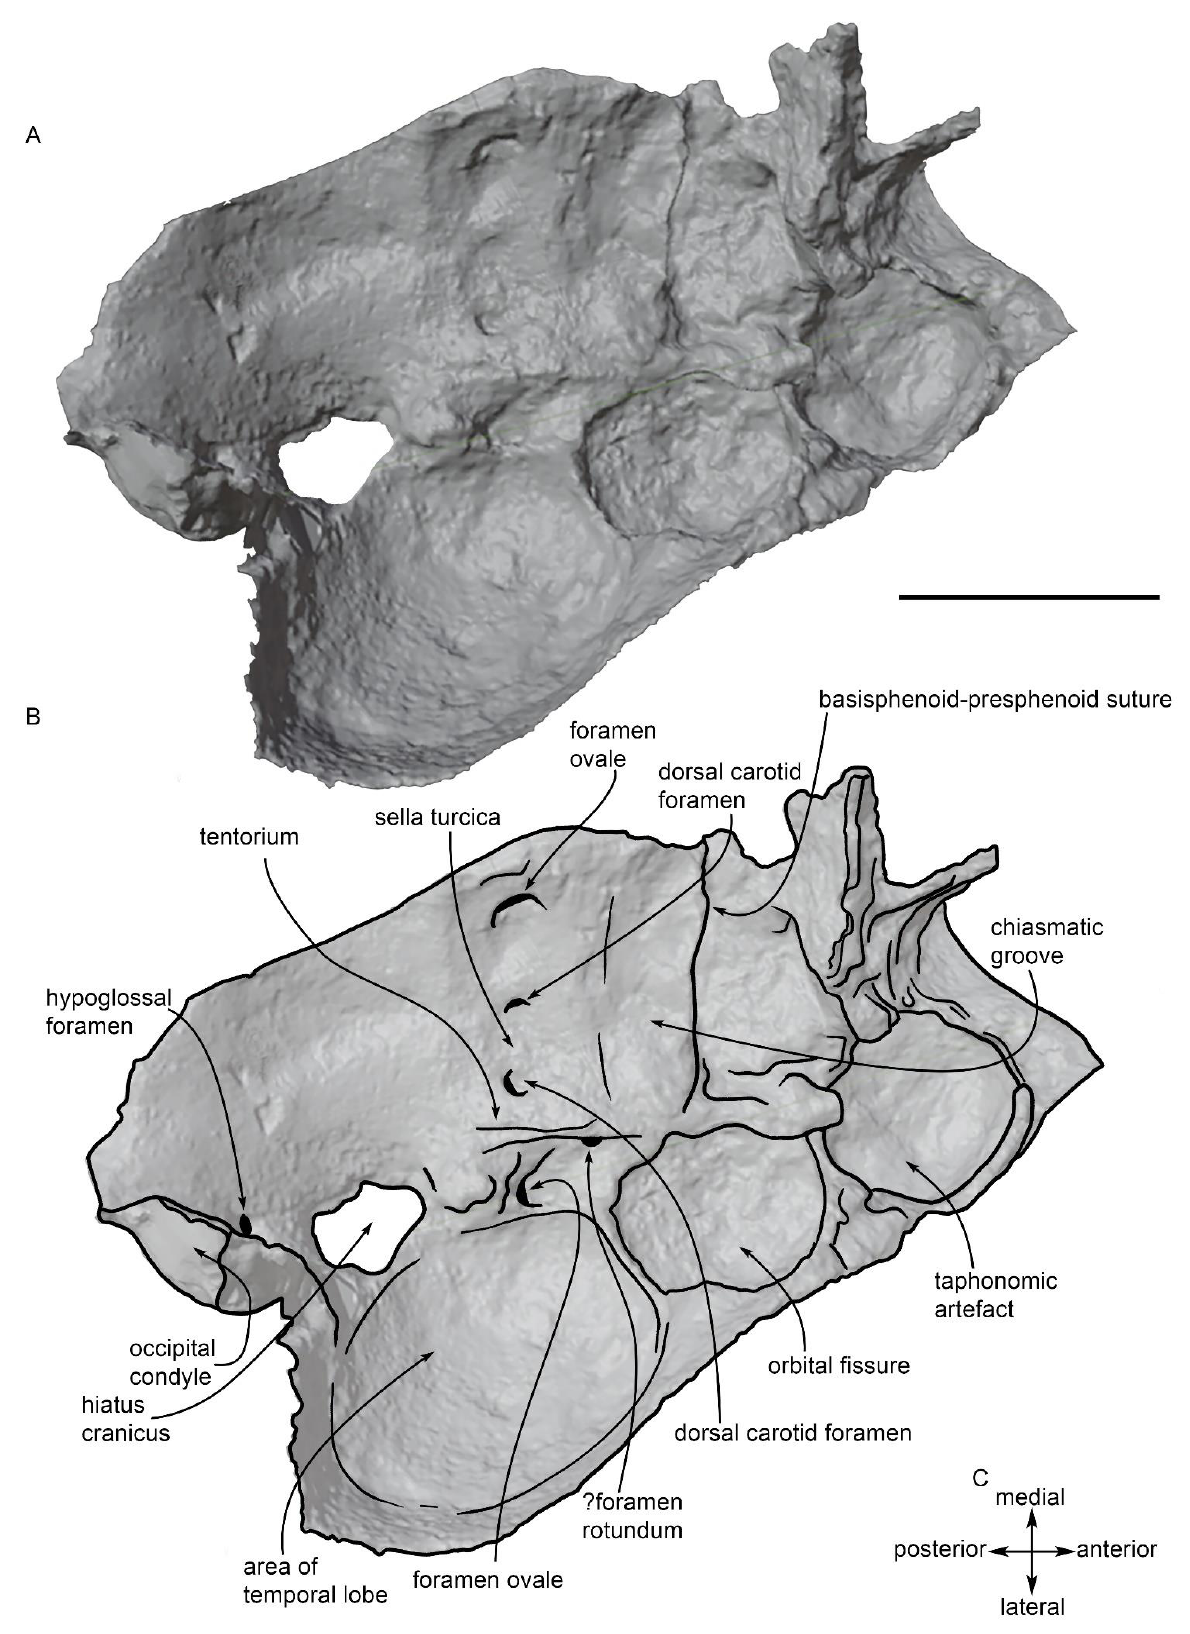
Figure 13. 3D virtual rendering of the basicranium of MGPT-PU 13881/1. ( A ) Software representation. ( B ) Anatomical interpretation. Scale bar equals 5 cm. ( C ) orientation of the basicranium.